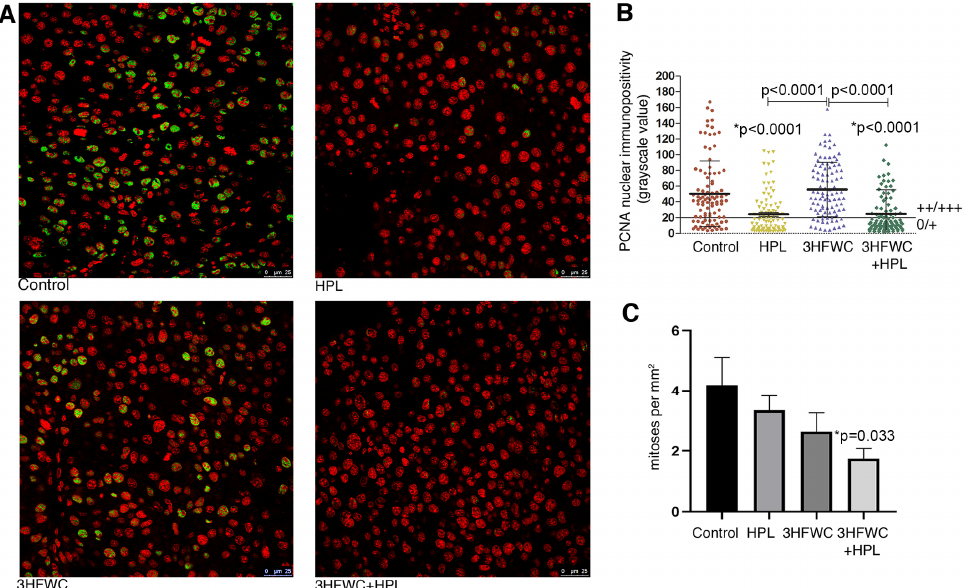
Figure 2. Inhibition of melanoma cells proliferation in vivo by HPL, 3HFWC, and HPL+3HFWC treatments, as demonstrated by ( A ) PCNA immunoexpression (green) in melanoma tissue, red signal—propidium iodide nuclear staining (scale bar and orig. magnification—25 μ m, × 63); ( B ) PCNA nuclear immunopositivity levels (0/+ no/weak immunopositivity; ++/+++ medium/strong immunopositivity of nuclei); and ( C ) mitotic index in melanoma tissue. Mean values ± SEM; statistical significance in comparison to melanoma tissue of control animals (* p value) and between the treated groups.